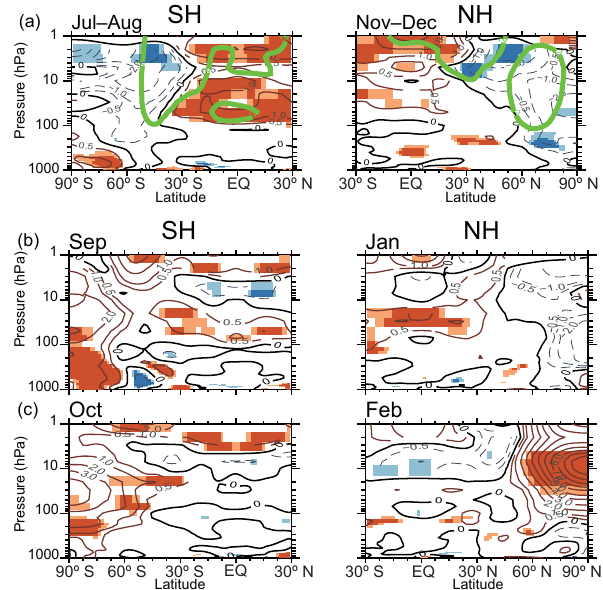
Figure 7. (a) Same as Fig. 6, except for 2-month mean air tempera- ture, July–August in the SH (left), and November–December in the NH (right). Green lines indicate 2ms − 1 contours of the correspond- ing zonal mean zonal wind. (b) Same as (a) , except for monthly mean temperature in September (left) and January (right). (c) Same as (b) , except for October (left) and February (right). The contour interval for temperature is